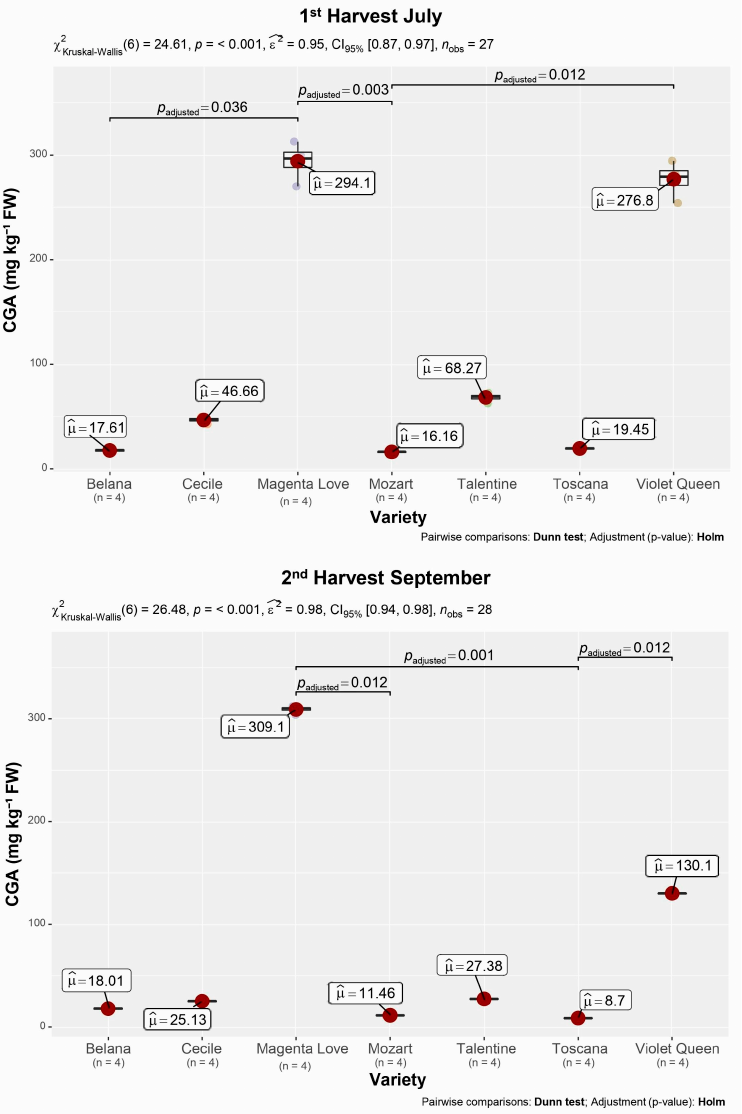
Figure 4. Statistical differences in chlorogenic acid content (CGA) between individual potato varieties harvested in July (1st harvest) and September (2nd harvest). The CGA content in samples from September was not higher in all potato varieties compared to July. Although the total anthocyanin and polyphenol contents increased sig- nificantly in all varieties (Tables 2 and 3), indicating a positive effect of the degree of ma- turity on the monitored bioactive substances, in the varieties Cecile, Mozart, Talentine, Toscana, and Violet Queen the CGA content decreased. The most significant decrease in CGA was recorded in the Talentine variety (by approx. 59.9%). A similar decrease during